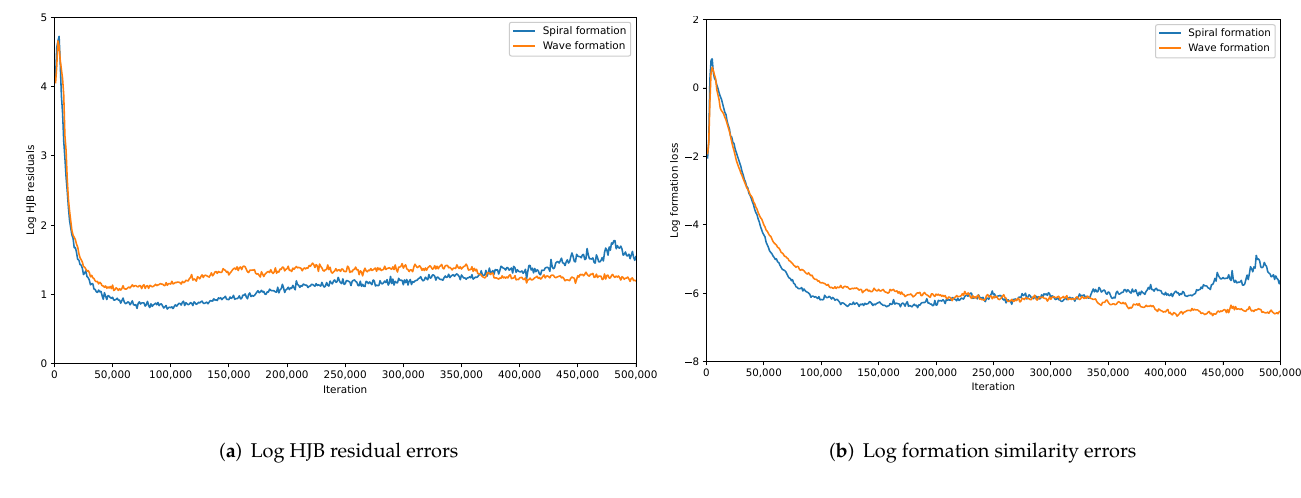
Figure 4. Illustration of MFG convergence and formation stability.